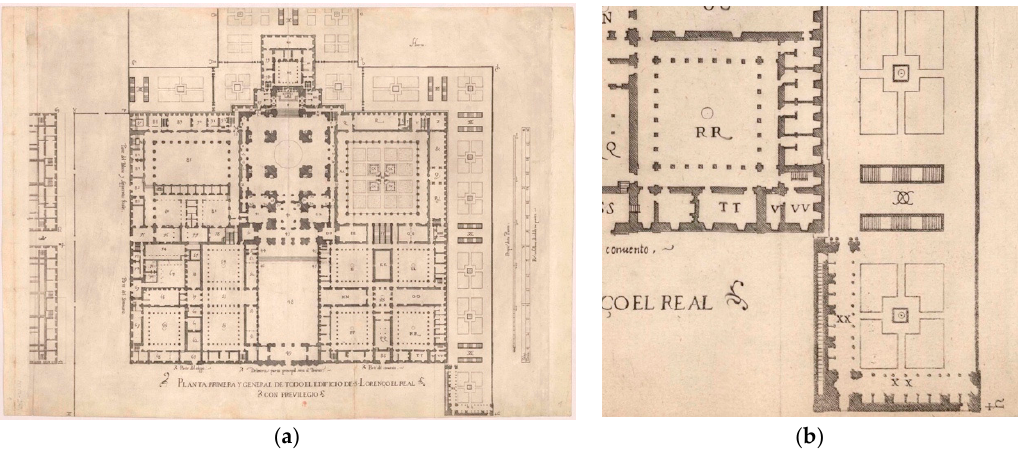
Figure 5. Juan de Herrera and Pedro Perret, 1587: Primer diseño. Planta general y primera de todo el edificio project by Juan Bautista de Toledo. He made known the appearance of the Monastery by a set of drawings engraved by Perret. ( a ) Ground plan of the Monastery, where north is to the left of the picture. ( b ) Detail of the southwest area where the Claustro de la Enfermer í a is lettered (RR), the Torre de la Botica (VV), and the Galer í a de Convalecientes (XX), opened up to the Jard í n de los Frailes . The thick wall at the bottom of the figure is the party wall between the Galer í a and the Botica , while this building was not included because there was no place available on the sheet. The party wall shows gates connecting the two buildings. Biblioteca Nacional de España, Madrid, Bookmark